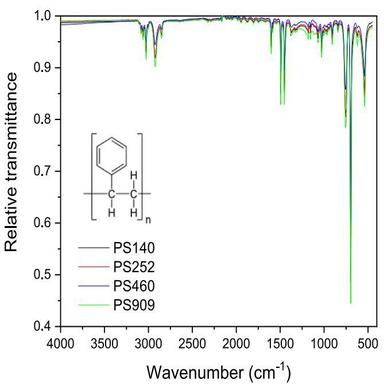
FTIR spectra of PS NPs with different particle sizes (140, 252, 460 and 909 nm).